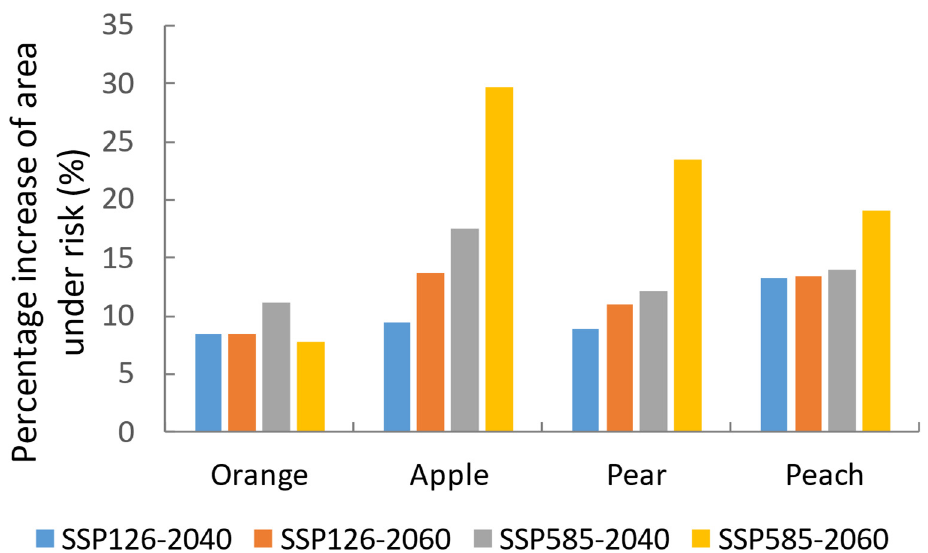
Figure 5. Percentage increase in area at risk of attack by B. dorsalis for four temperate fruit species, comparing four future climate scenarios/years to the current situation. Under the current situation, risk area for orange is 1.96 million hectares, apple 1.75 million hectares, pear 0.78 million hectares, and peach 0.52 million hectares.